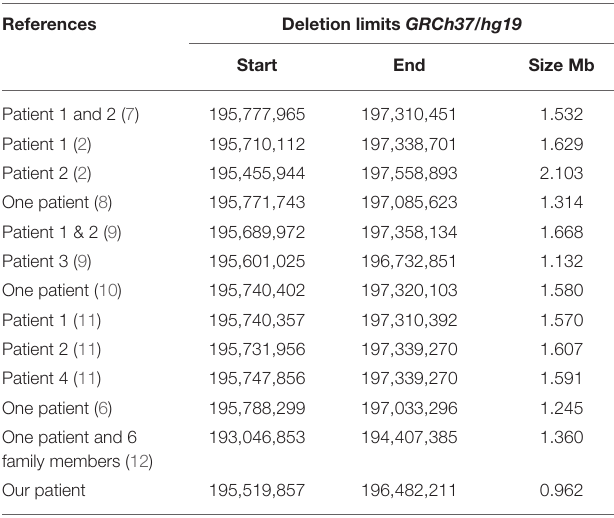
TABLE 2 | Deletion limits reported in literature using array platforms illustrated in Figure 3